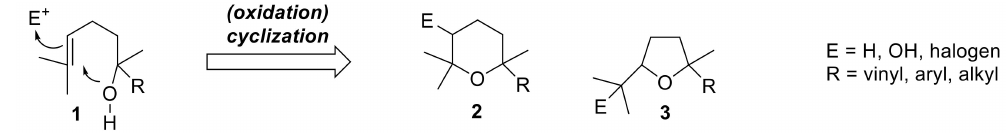
Figure 1. The transformation of terpenic alcohols of type 1 into tetrahydropyrane and tetrahydrofurane derivatives 2 and 3 , respectively.